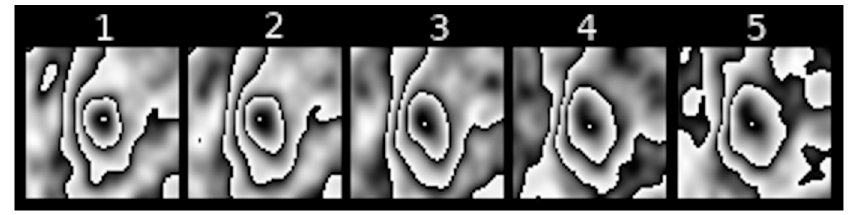
Figure 6. Example of a sequence of transformed PET images of a pulmonary nodule with moder- ately altered shape of [18F] FDG uptake contours.